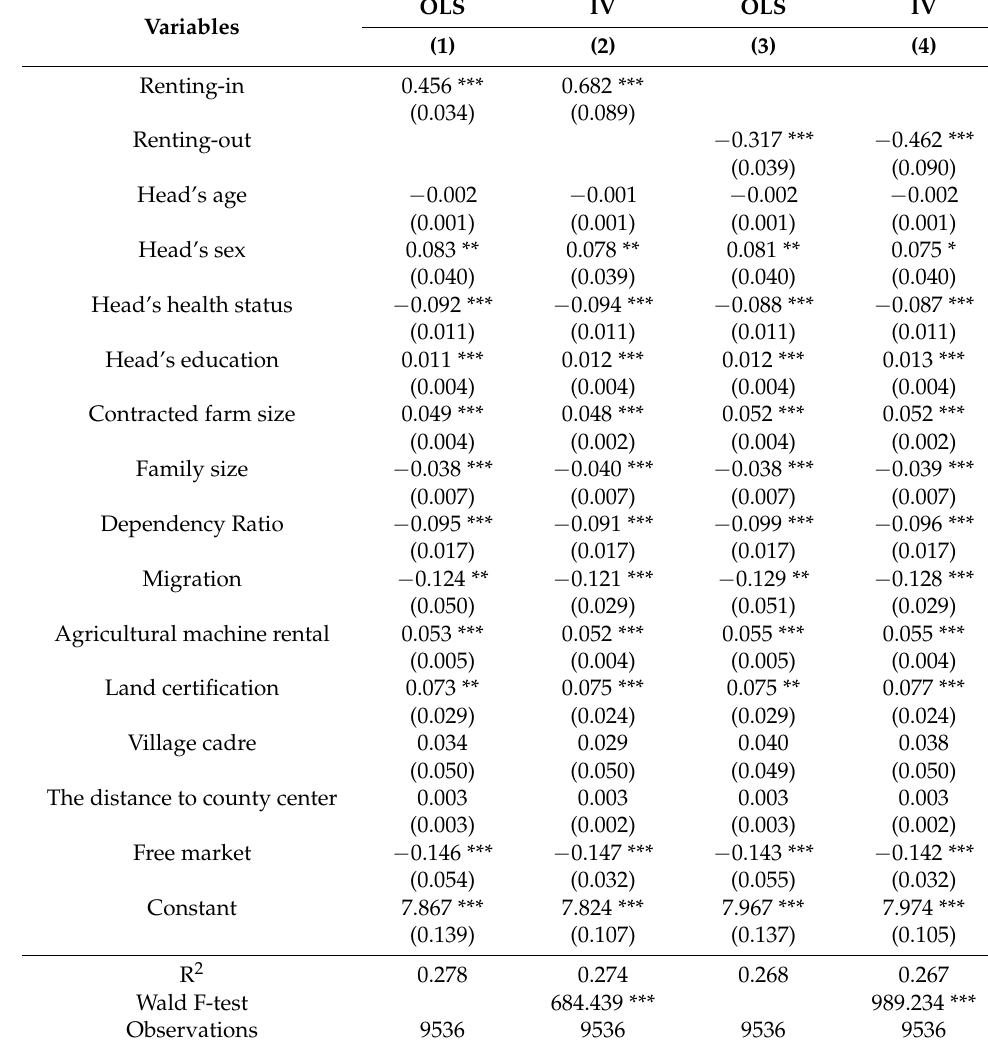
Table 4. The effects of land rentals on household labor productivity, instrumental variable